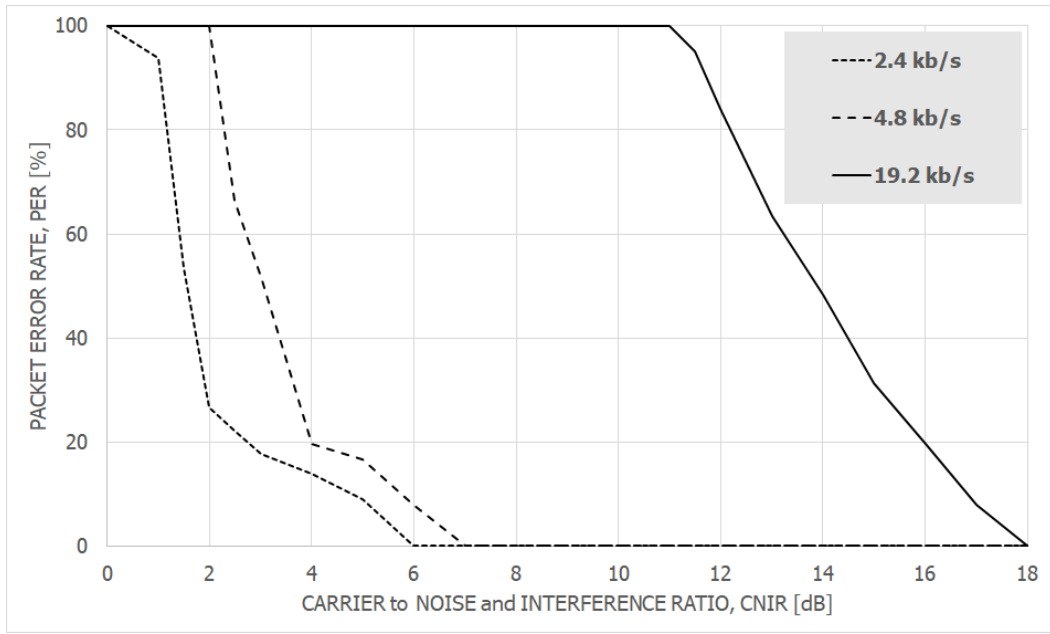
Figure 7. Packet Error Rate (PER) response to interference (jamming) expressed by carrier to inter- ference and noise (CNIR) obtained in the LKE (WUST) anechoic chamber (169 MHz).